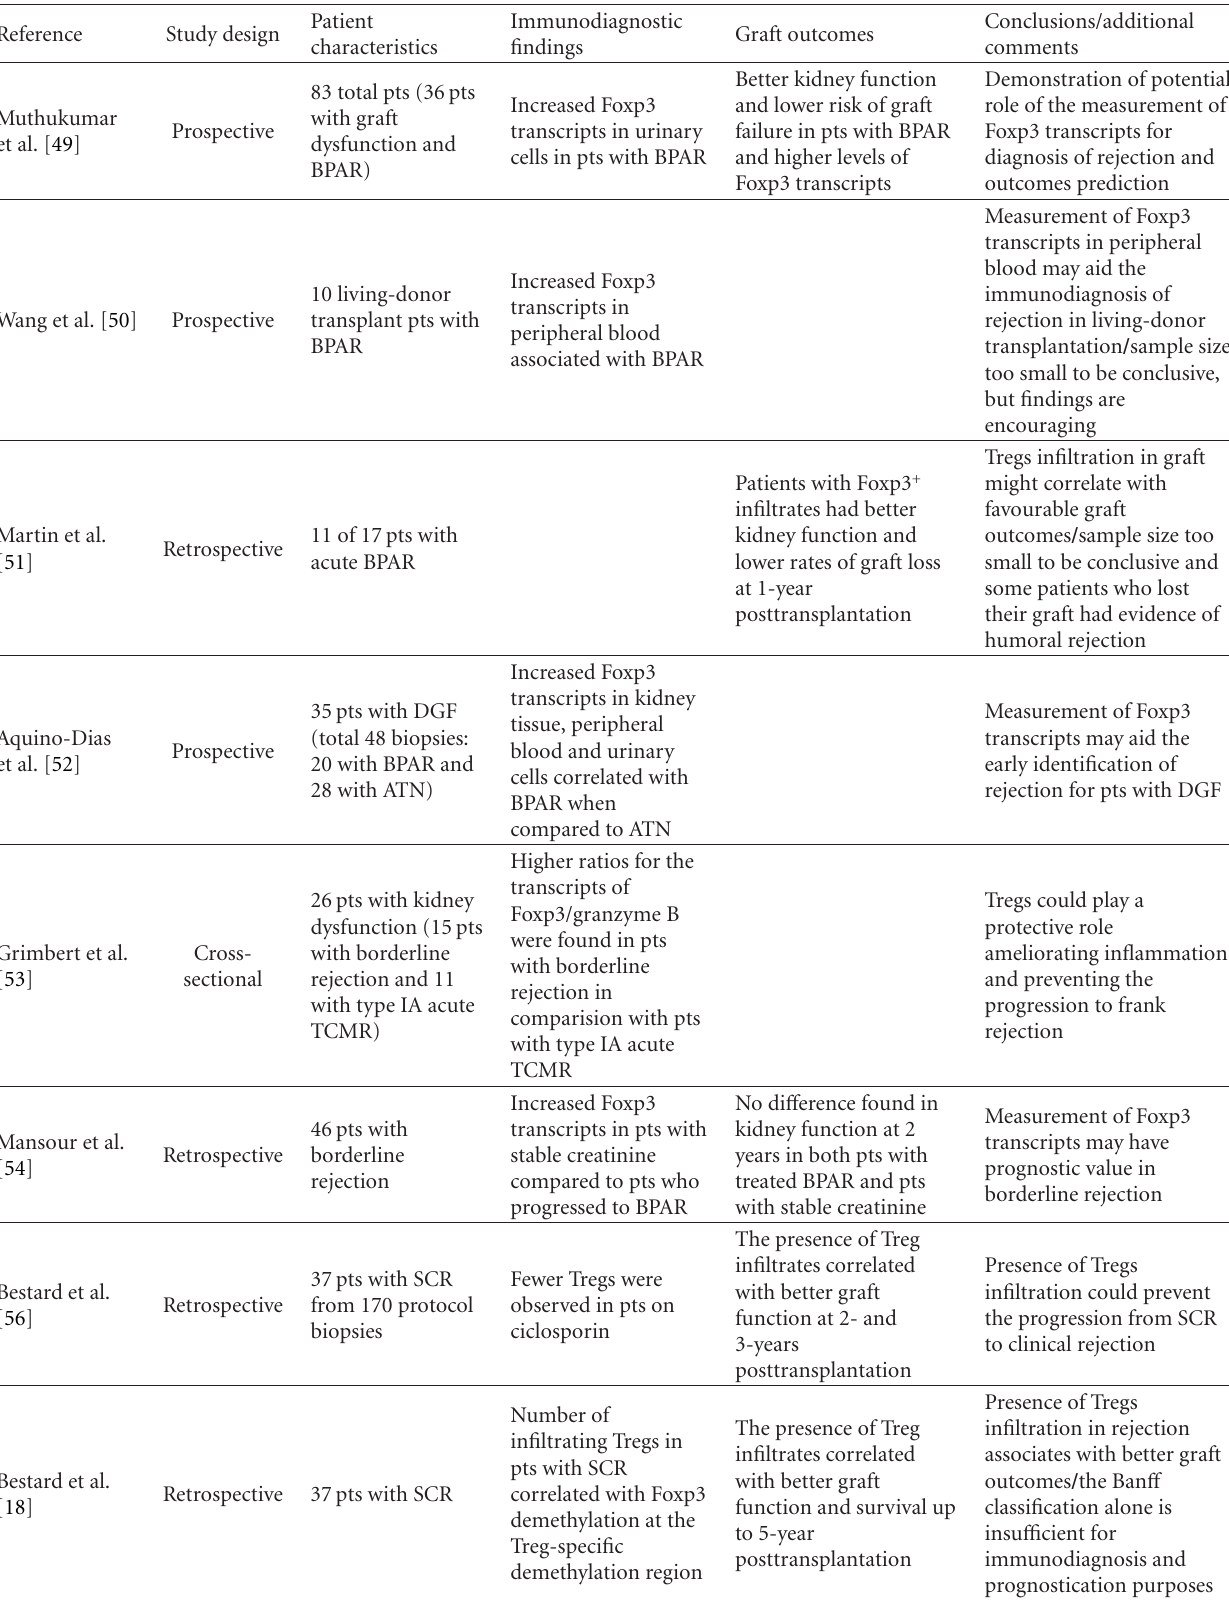
Table 1: Studies supporting the association of regulatory T cells with diagnosis of kidney rejection and graft outcomes